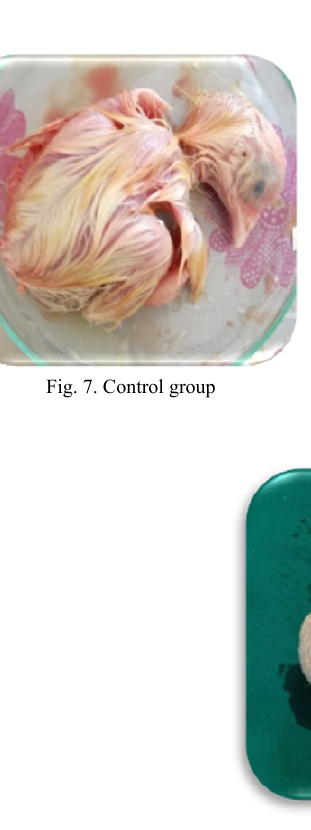
Fig. 9. Teratogenic effects were including Fig.8. Teratogenic effects were including deformity of legs and wings deformity of legs and